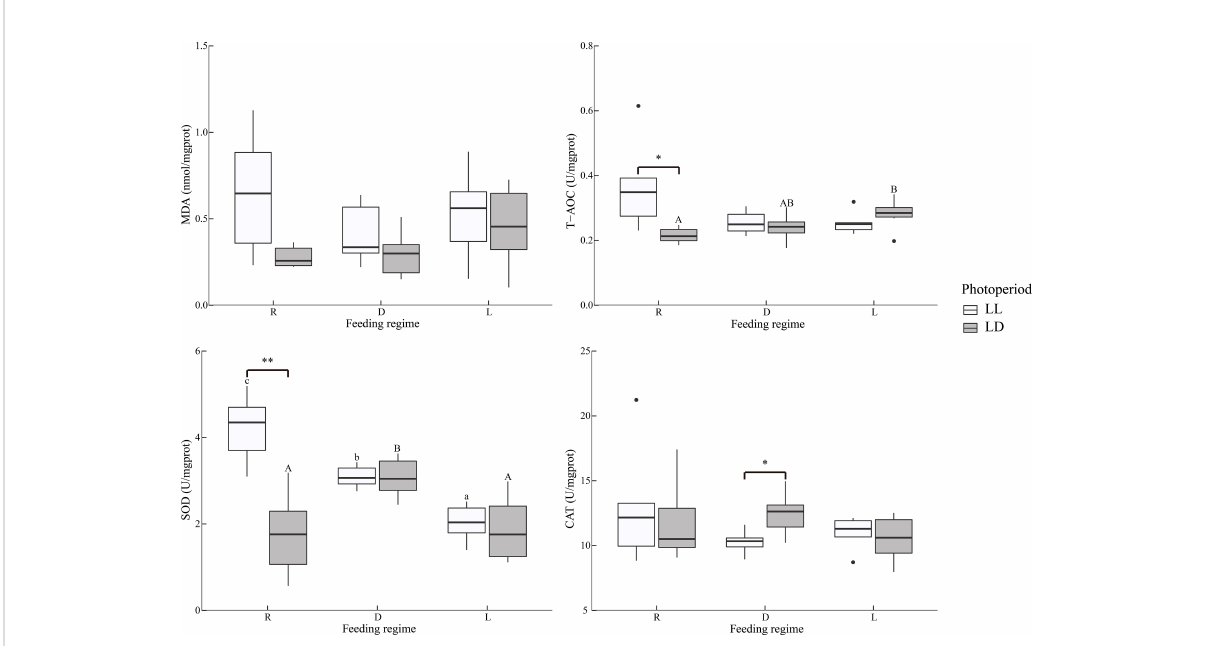
FIGURE 5 Dorsal muscle antioxidant indicators of juvenile Oncorhynchus mykiss under different experimental treatments (n=6). MDA, Malondialdehyde; T- AOC, Total antioxidant capacity; SOD, Superoxide dismutase; CAT, Catalase; R, random feeding; D, mid-dark stage feeding; L, mid-light stage feeding; LL: 24L: 0D, LD: 12L: 12D. Different lowercase letters and capital letters indicate signi fi cant difference among different feeding regimes at the LL (24L: 0D) and LD (12L: 12D, lights-on at 6:00), respectively ( P < 0.05). Asterisks denote signi fi cant differences between photoperiods at the same feeding regime (* P < 0.05; ** P < 0.01). Points outside the box plot are